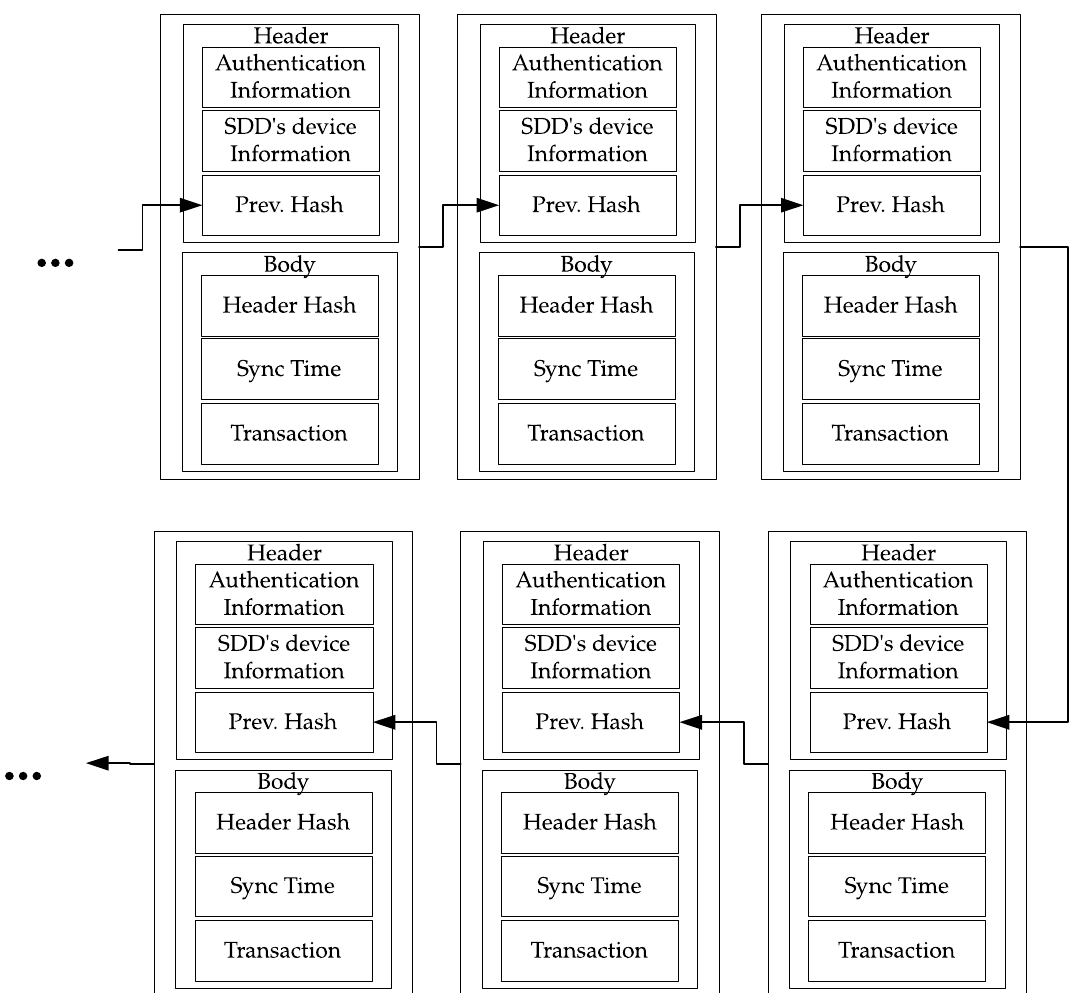
Figure 4. The lightweight blockchain proposed for smart dust IoT environments. Table 2. Fields of